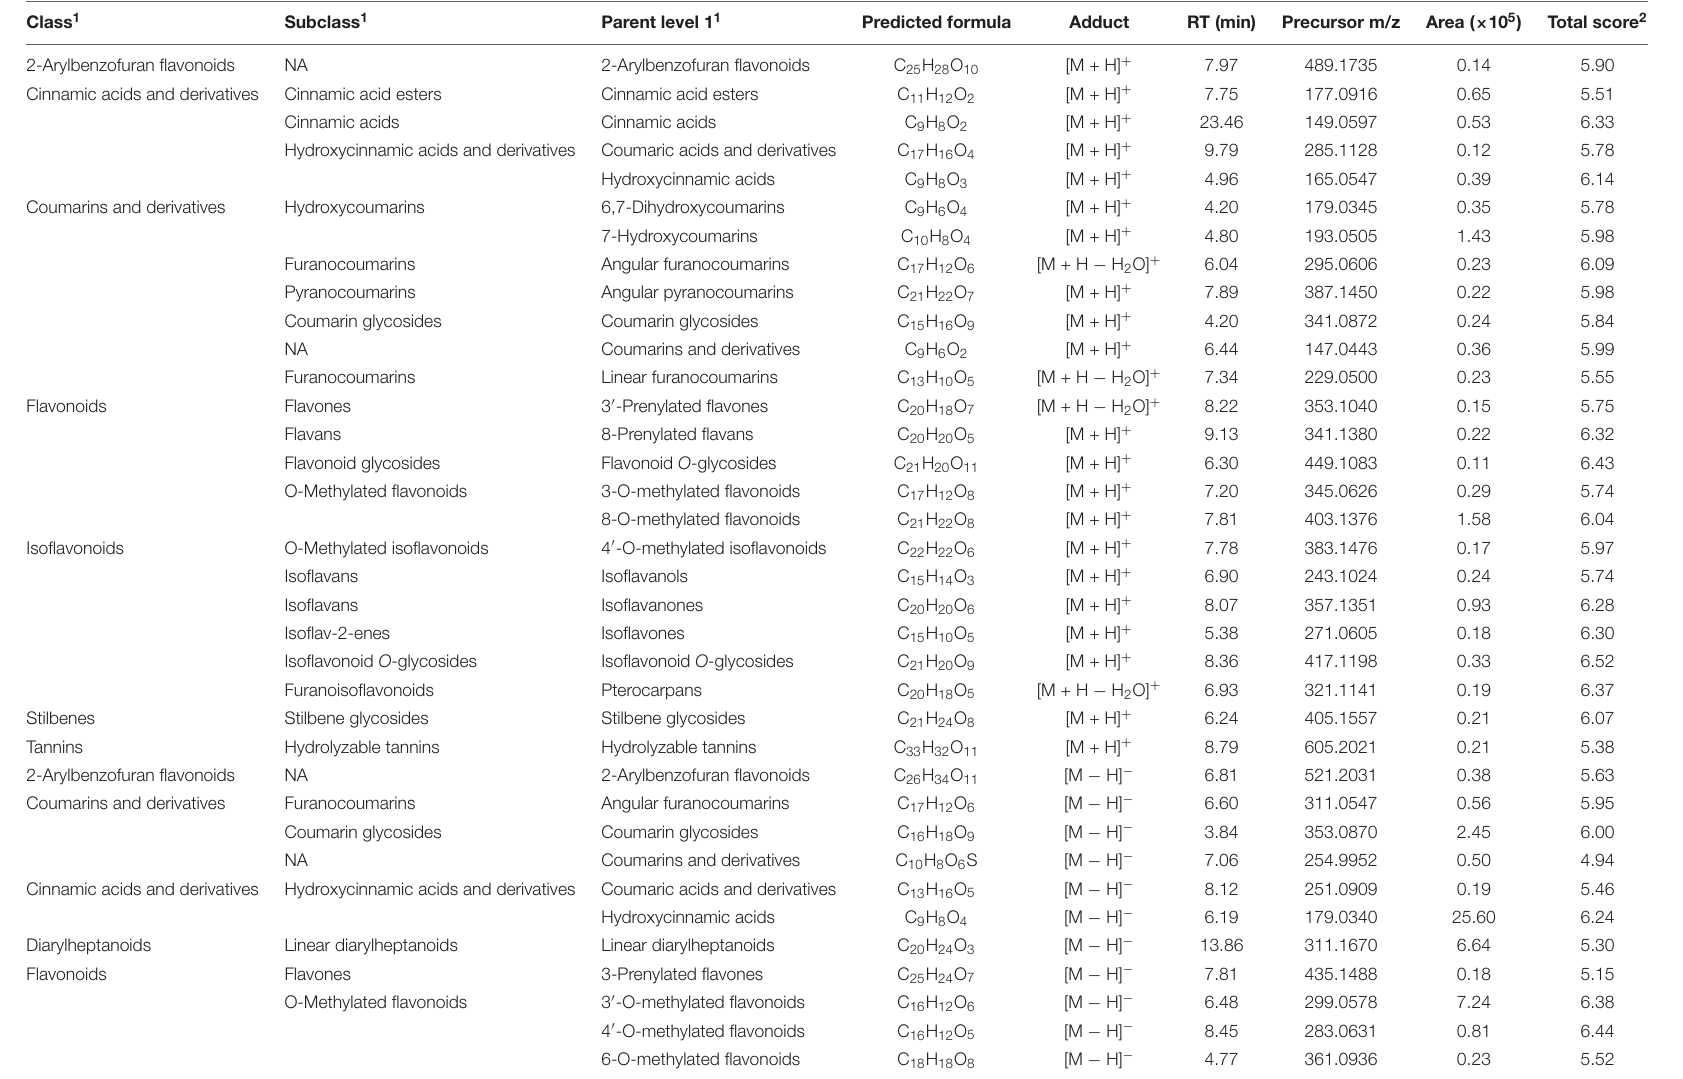
TABLE 2 | Polyphenolic compounds of interest in